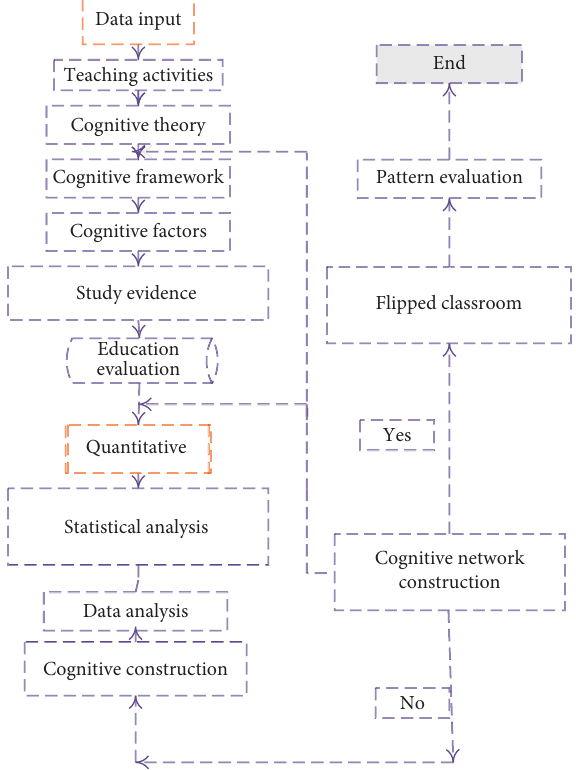
Figure 2: Process of flipped classroom teaching evaluation model based on learner cognitive network